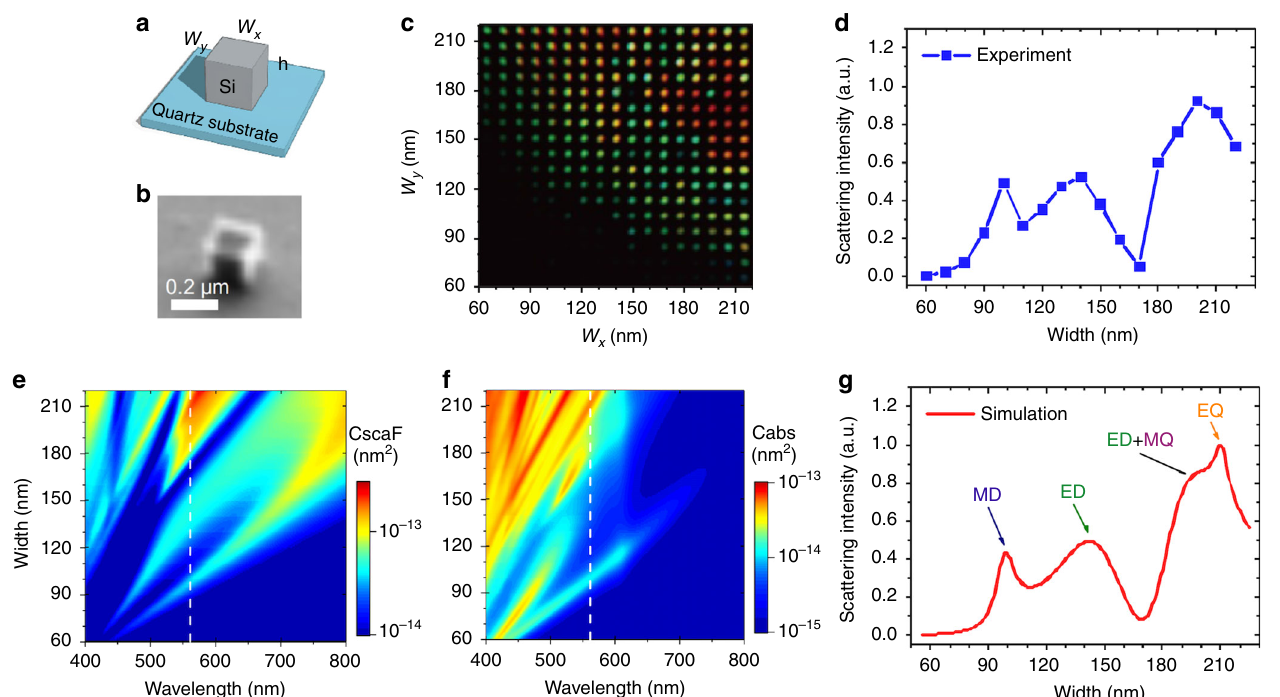
Fig. 1 Optical properties of Si nanostructures. a We used Si nanoblocks on a quartz substrate, whose lateral dimensions ( w x and w y ) vary from 60 to 220 nm, with a 10-nm step, and a fi xed height (h) of 150 nm. b Focused ion-beam image of a typical Si nanoblock ( w x = w y = 200 nm). Resolution is compromised because of the charging effect of the non-conductive quartz substrate. c Halogen lamp illuminated dark- fi eld image of the isolated Si nanoblocks, showing colorful resonance among different sizes. d 561-nm scattering intensity along the array diagonal ( w = w x = w y ), presenting the characteristic multipole resonance of silicon nanostructures. The excitation intensity is 1.3 mW μ m − 2 . e Simulated single-particle forward scattering (CscaF) and f absorption cross section (Cabs) spectra versus different nanoblock widths. The white dashed line marks the 561-nm laser, which excites multiple resonances. g Simulation of size-dependent 561-nm scattering, which agrees well with experiment results. MD magnetic dipole, ED electric dipole, EQ electric quadrupole, MQ magnetic